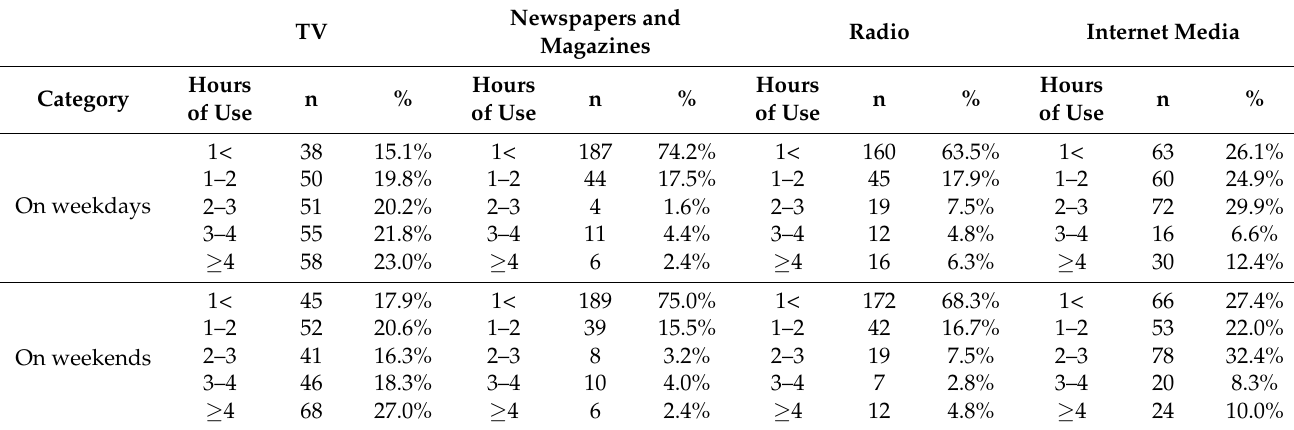
Table 2. Media usage of the